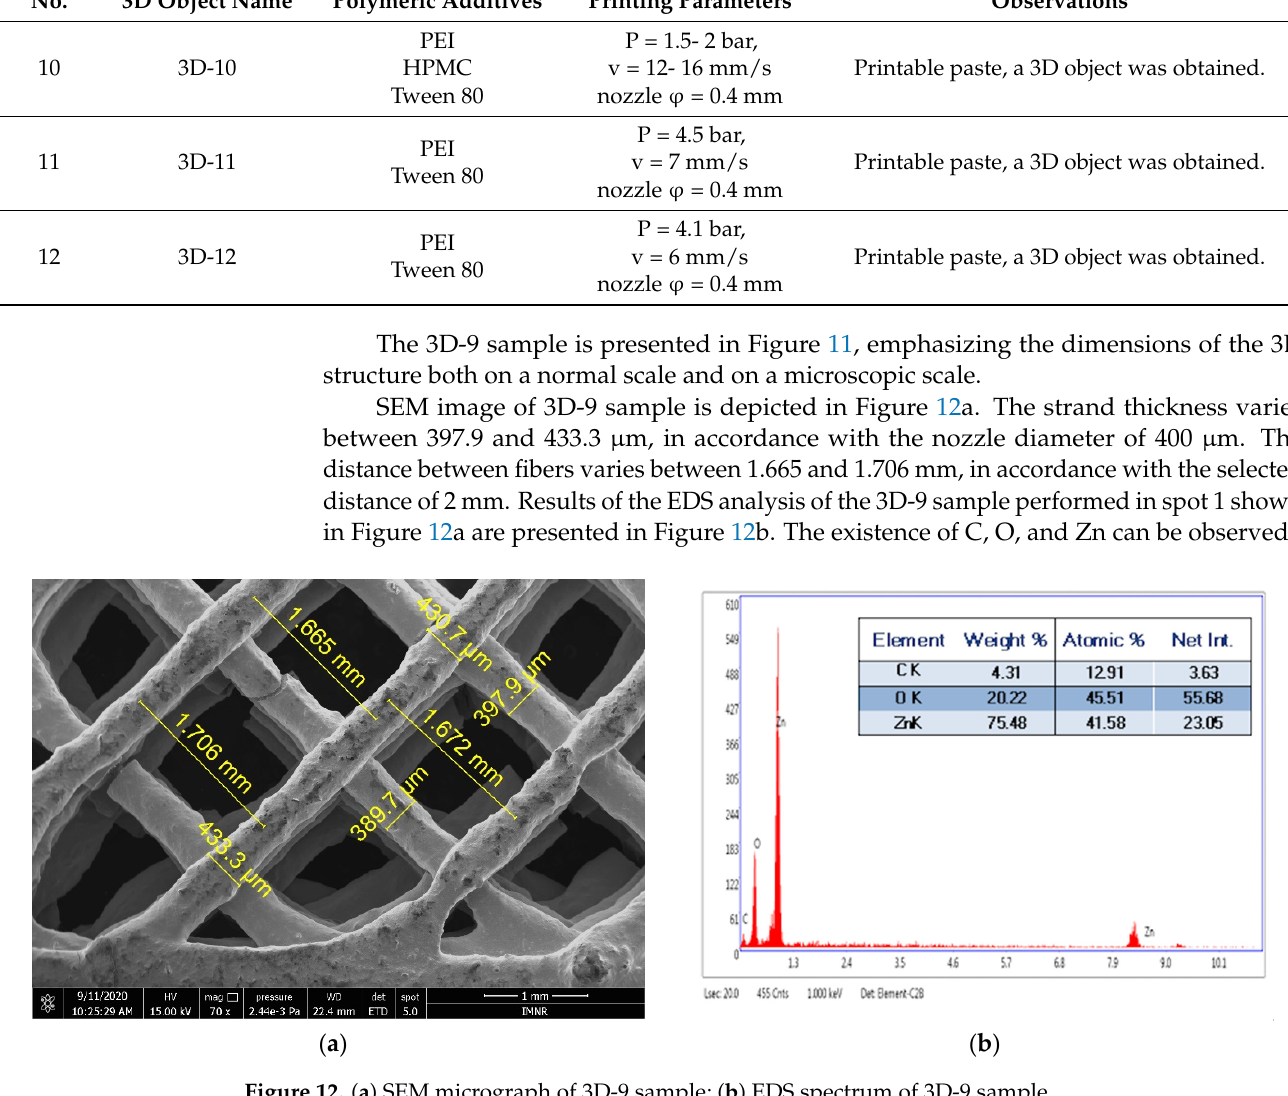
Figure 12. ( a ) SEM micrograph of 3D-9 sample; ( b ) EDS spectrum of 3D-9 sample.